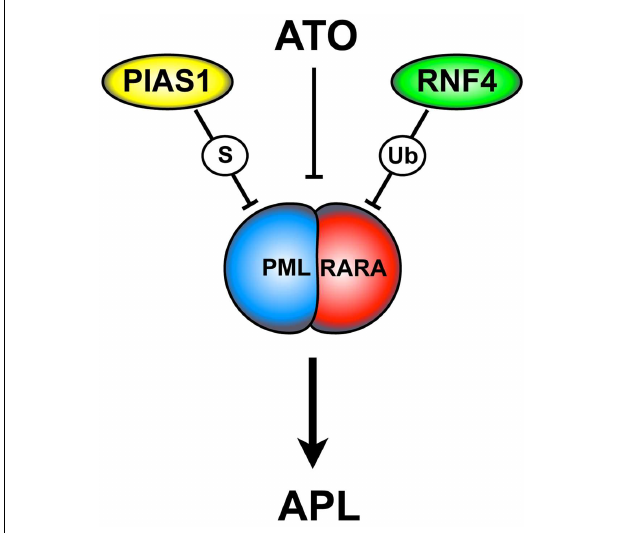
FIGURE 2 |ATO-dependent PML-RARA SUMOylation and degradation. ATO triggers PML-RARA degradation leading to APL remission.This process requires the PIAS1 SUMO E3-ligase and the ubiquitin E3-ligase RNF4. ATO is thought to directly bind to the PML moiety of PML-RARA.This event causes a conformational change that allows PML-RARA poly-SUMOylation and its interaction with RNF4. ATO, arsenic trioxide; S, SUMOylation; Ub,